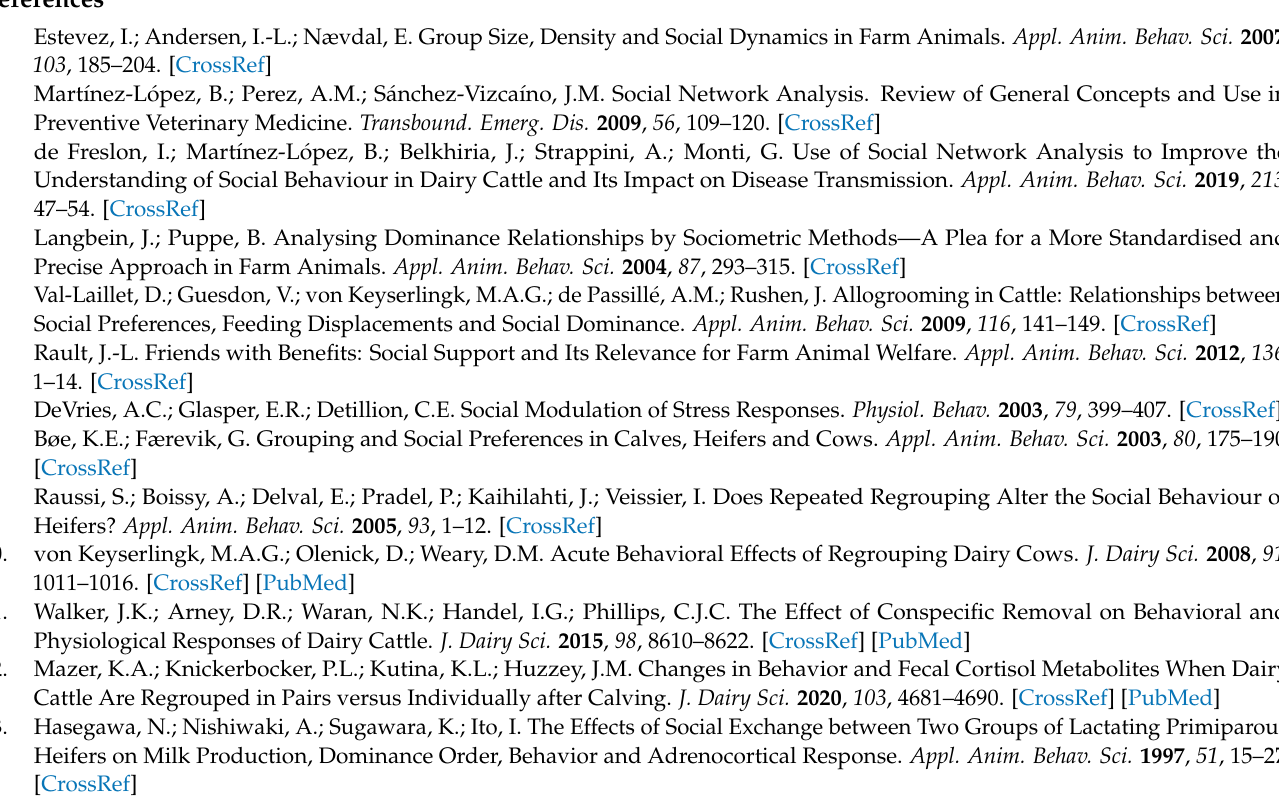
Figure A2. Overlap of periods of social affinity as a function of days in milk. The density of observations in periods of social affinity (green) and non-social affinity (red) have similar distributions.